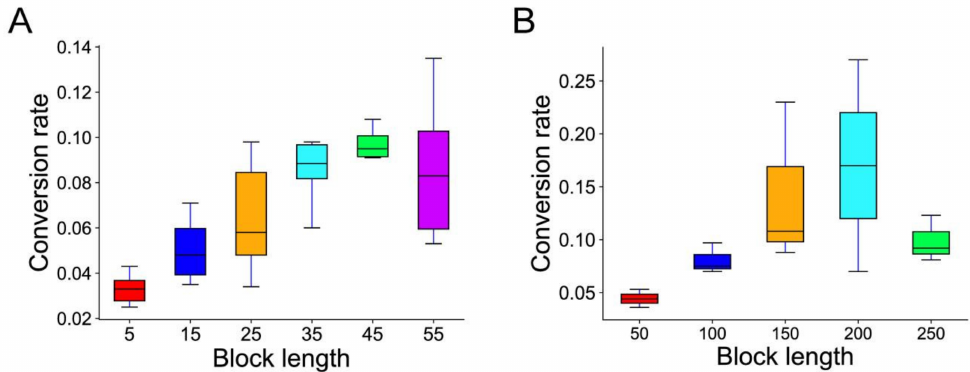
Figure 5. The association between the block length (colinear gene pairs) and the gene conversion rate. ( A ) The association between LCT-related block length and conversion rate among all eight peanut genomes. ( B ) The association between PRT-related block length and gene conversion among three tetraploid peanut